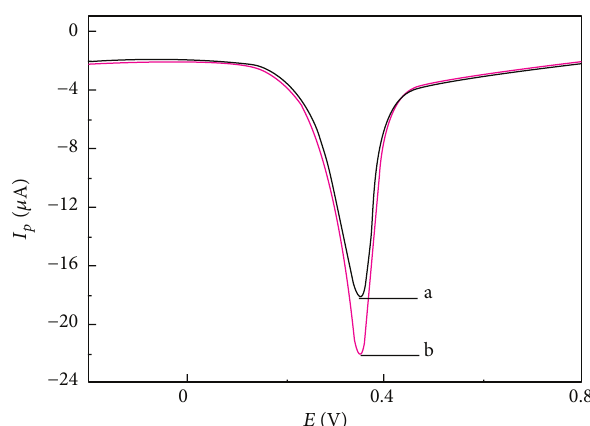
Figure 3: Cyclic voltammogram of bare glassy carbon electrode (Curve a) and poly-L-histidine modified electrode (Curve b).